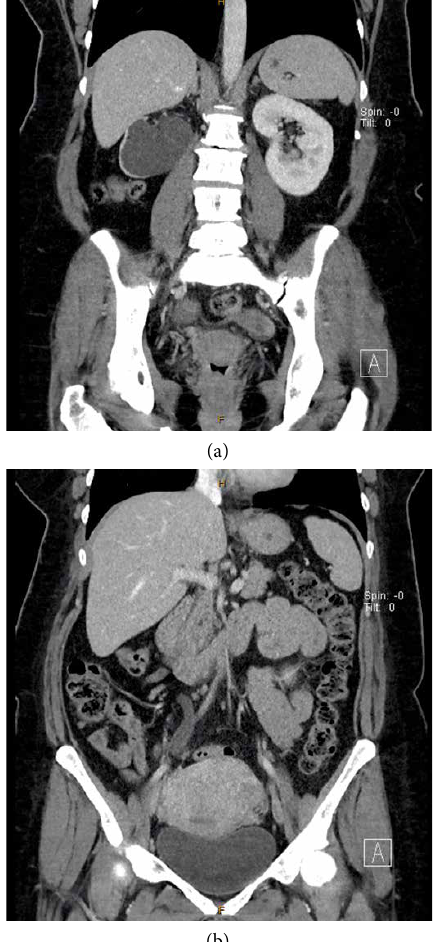
Figure 2: CT urogram confirmed significant right hydronephrosis with marked thinning of the renal parenchyma (a), and right hydroureter at the level of the pelvic brim where it crosses the common iliac artery